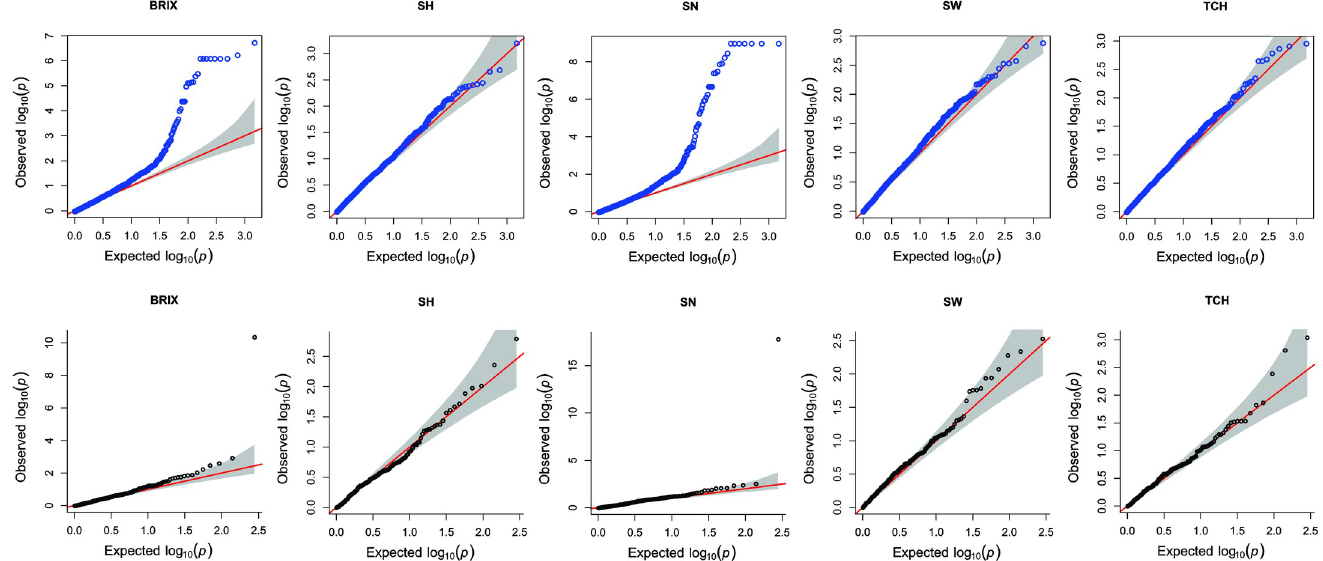
Fig 4. QQ plots using GAPIT (graphs with blue dots) and FarmCPU (graphs with black dots) software. The dotted lines show the 95% confidence intervals for the QQ plots under the null hypothesis of no association between the SSR fragment and the trait.